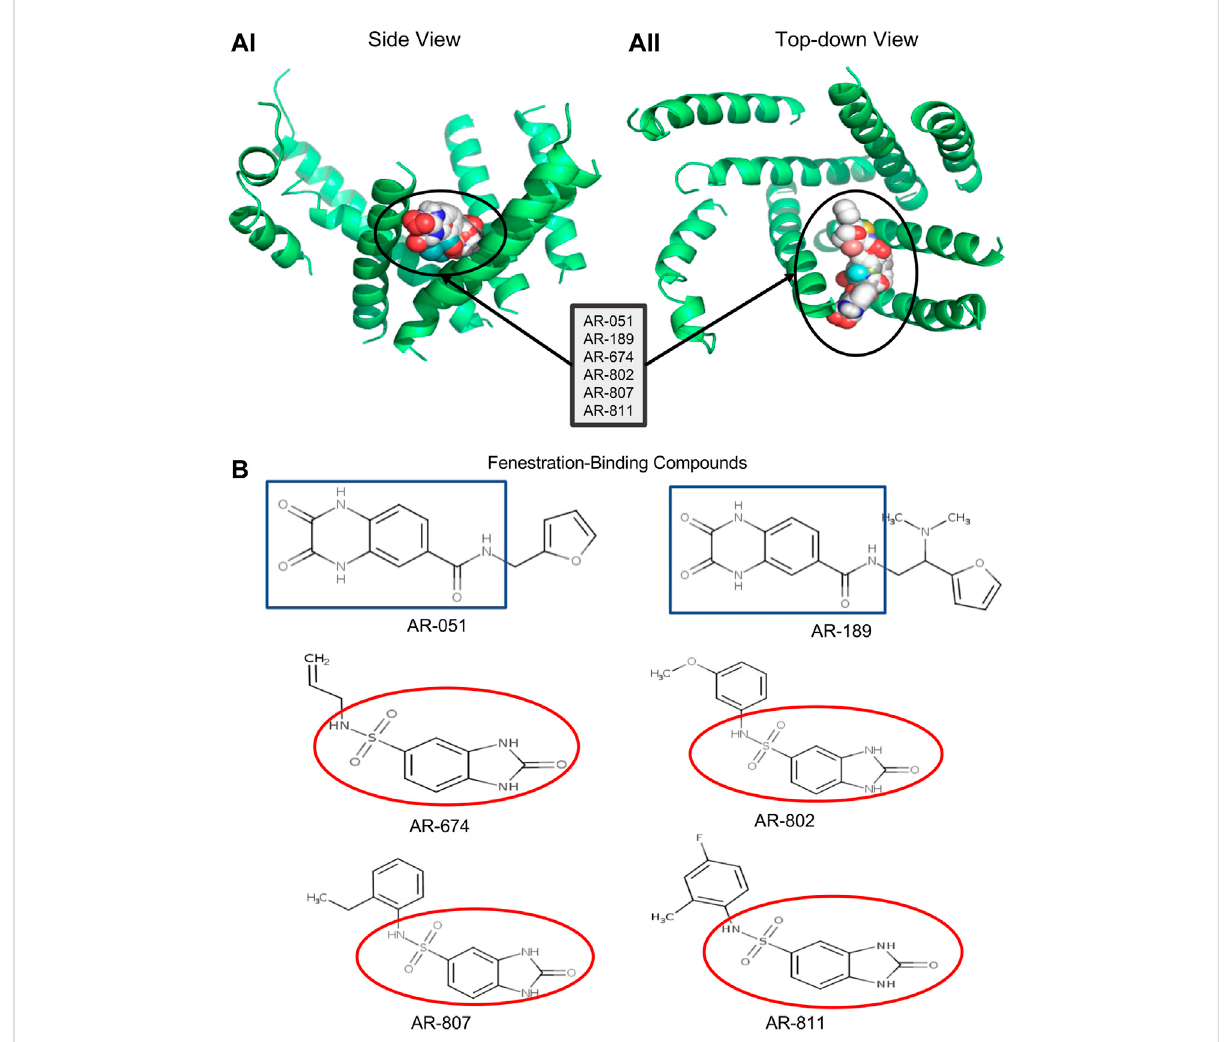
FIGURE 1 Docking ARumenamide. (AI, AII) display the virtual docking results for ARumenamide compounds screened against Nav1.5 -NavAb from the side and top-down views, respectively. The highestbinding af fi nity mode is shown for thesix ARumenamide compounds: AR-051; AR-189; AR-674; AR-802; AR-807; and AR-811. All these compounds have a favorable af fi nity to Domain III-IV fenestration (circled). The compounds are shown as spherical representations. (B) shows the chemical structure of the docked ARumenamide compounds. The common backbone is